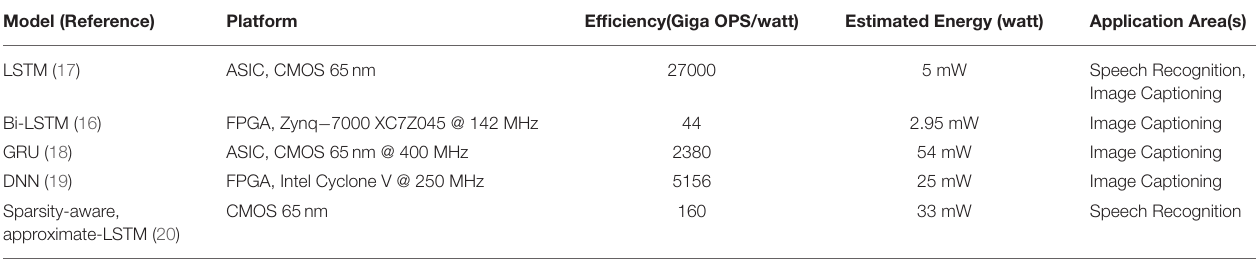
TABLE 1 | Energy consumption estimation for typical